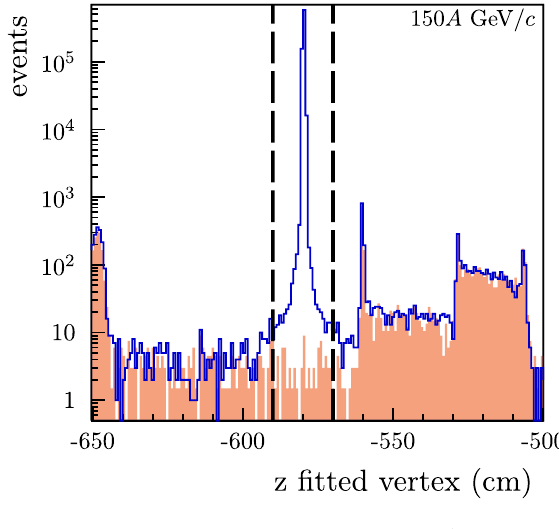
Fig. 5 Distribution of fitted vertex z coordinate for T2 triggered events of Ar+Sc interactions at 150 A GeV / c with target inserted and target removed (shaded histogram). The distribution for the data recorded with the Sc target removed was divided by a factor of N I / N R , where N I and N R are the numbers of events with Sc target inserted and removed in the range of fitted vertex z coordinate − 450 cm < z < − 300 cm, respectively. Vertical dashed lines show the acceptance region